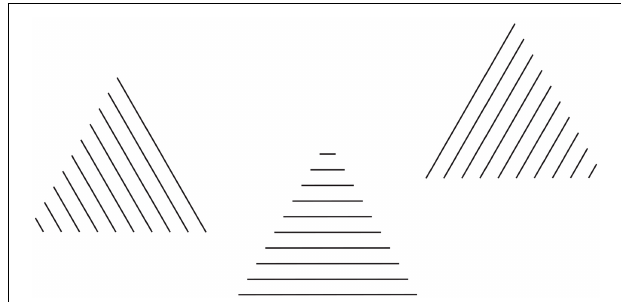
FIGURE 12 | The same equilateral triangle, made up of straight lines with different orientations, is perceived pointing in different directions on the basis of the direction of the arrangement of lines.